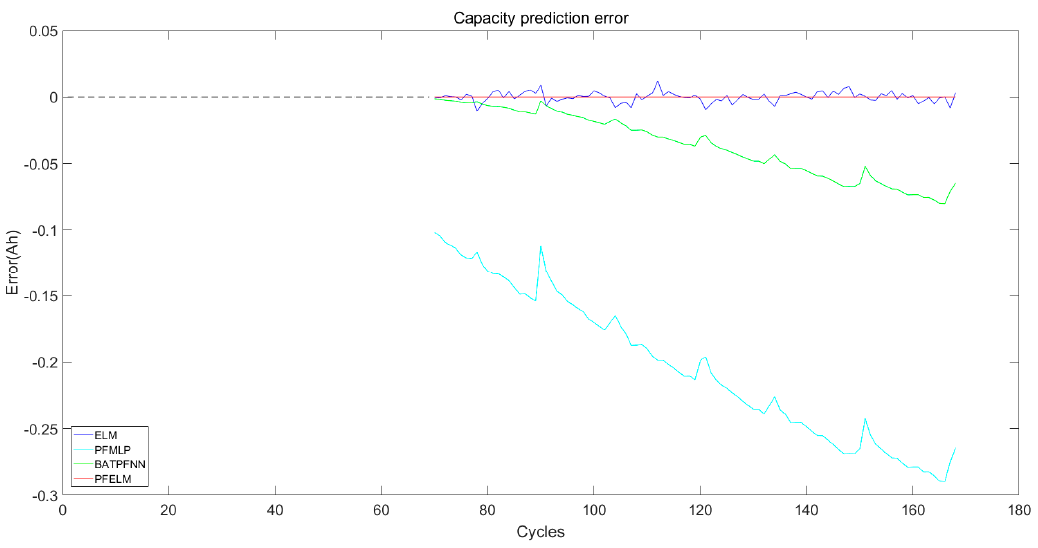
Figure 8. Predicting capacity from the 70th cycle by different algorithms: ( a ) ELM ; ( b ) PFMLP; ( c ) BATPFNN; ( d ) PFELM.